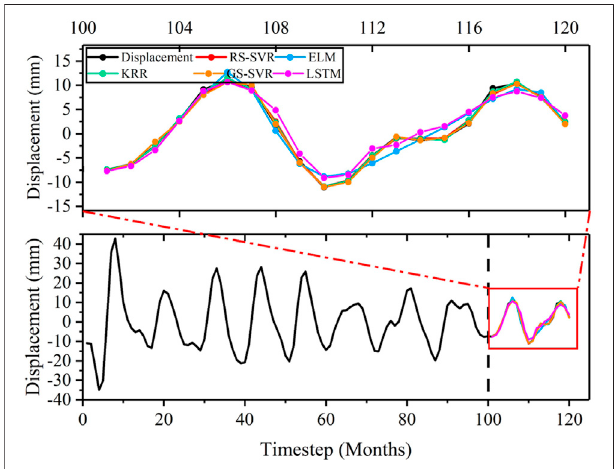
FIGURE 11 | Plots showing a comparison of prediction accuracy of the periodic displacement for multiple